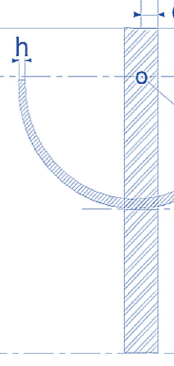
Figure 12. Two-dimensional view of HRG under simulation.